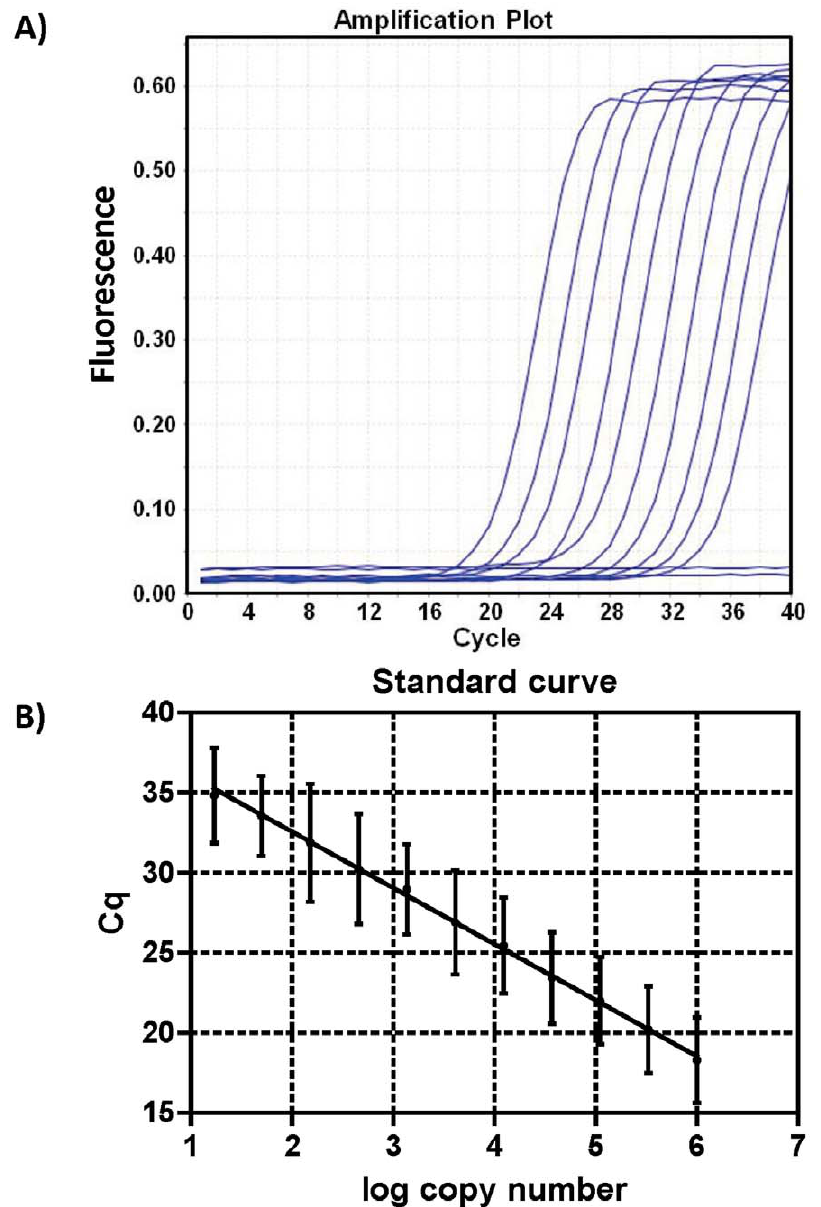
Figure 4. Analytical performance of qMSP with SYBR Green and methylation-specific primers. A) Amplification plot of a three-fold serial dilution of unmethylated plasmid showing the fluorescence versus cycle using P12 and P13 as methylation-specific primers. B) Standard curve plot showing C q versus log copy number of three-fold serially diluted bisulfite-treated unmethylated plasmid and the data shown are the average of 12 repeats with standard deviation (SD).